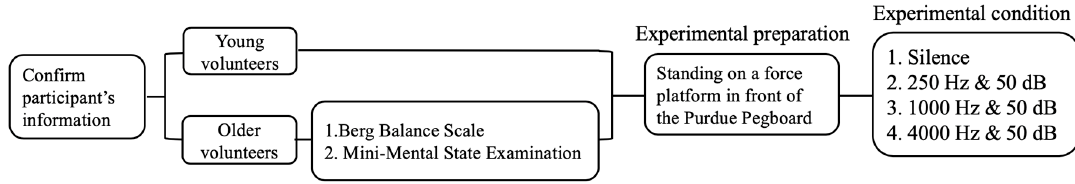
Figure 1. The flowchart of the experimental protocol.